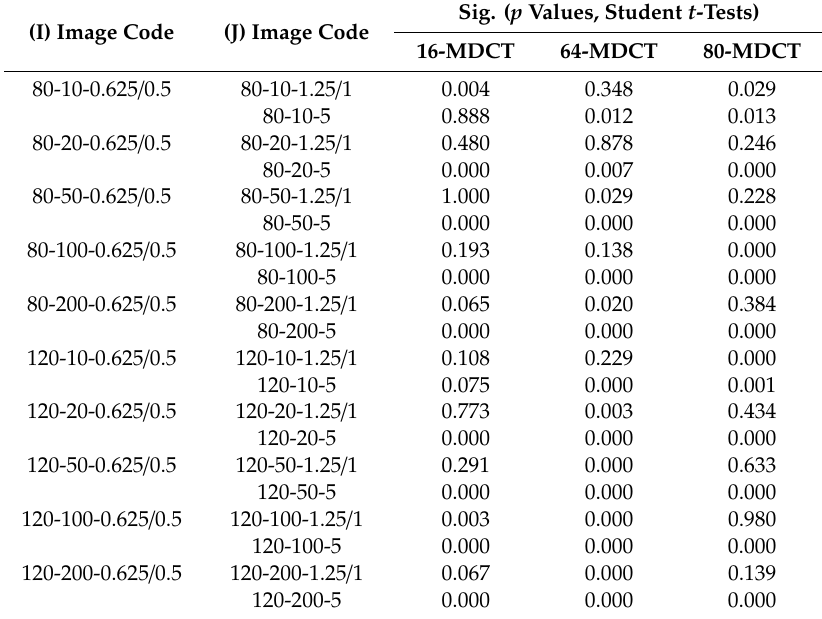
Table 8. Dissimilarities ( p values, student t -tests) between the images using the same kVp and mAs with varying section thickness in each CT